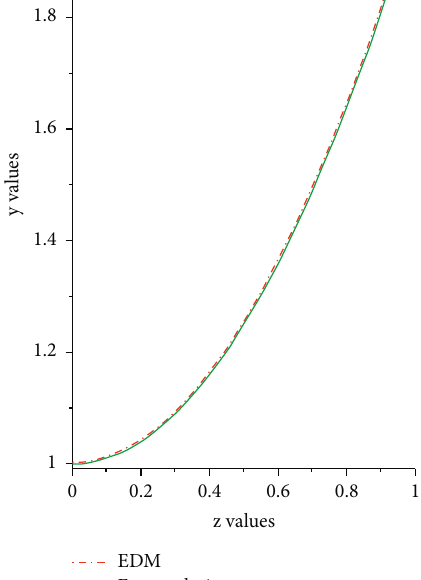
Figure 1: The approximate solution y